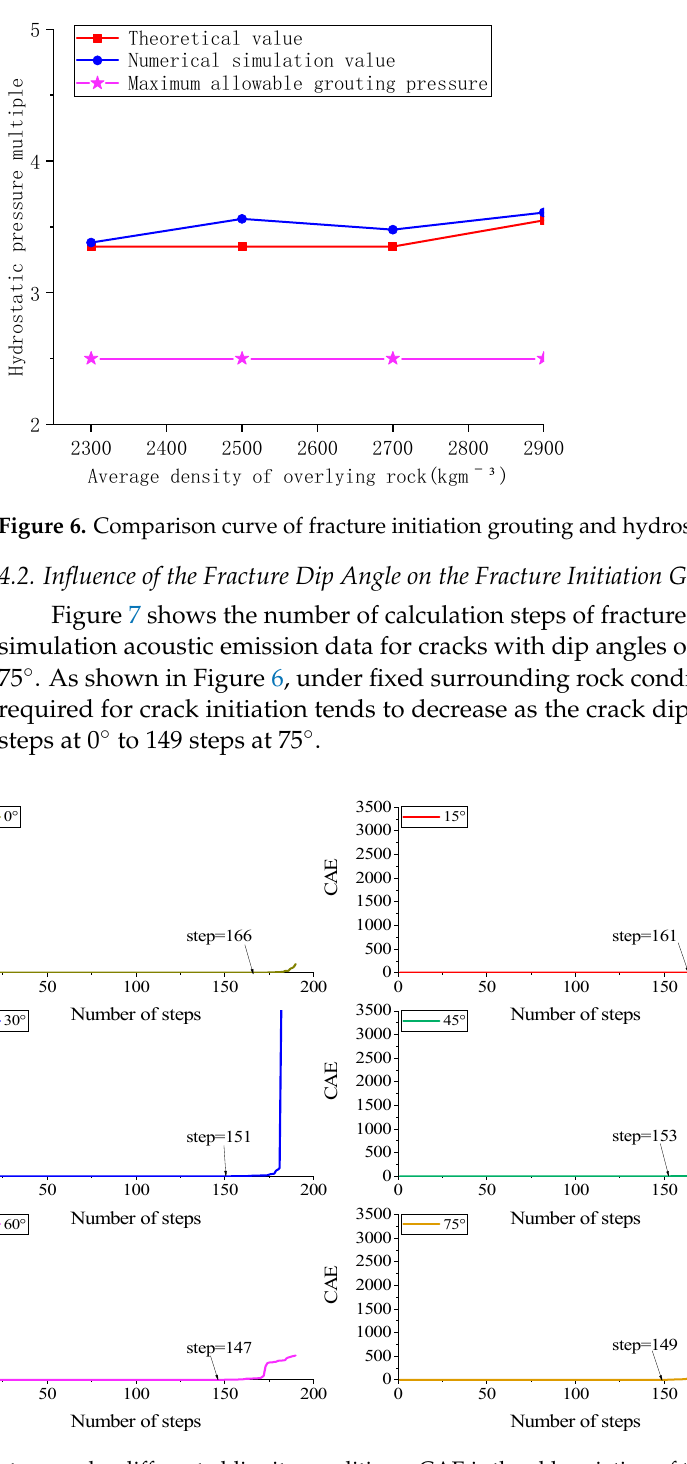
Figure 7. Fracture initiation steps under different obliquity conditions. CAE is the abbreviation of the Cumulative Acoustic Emission.